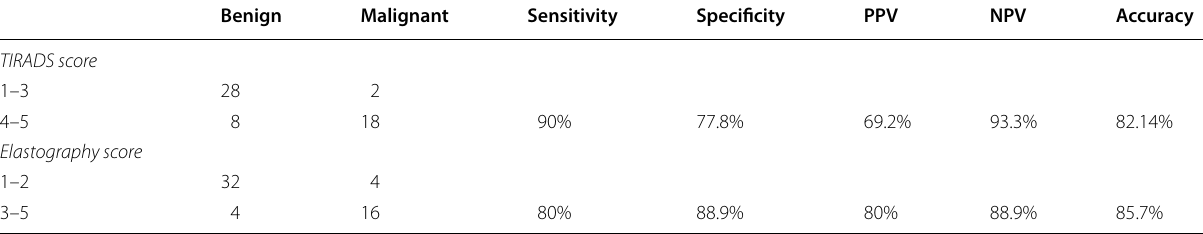
PPV, Positive predictive value; NPV, Negative predictive value